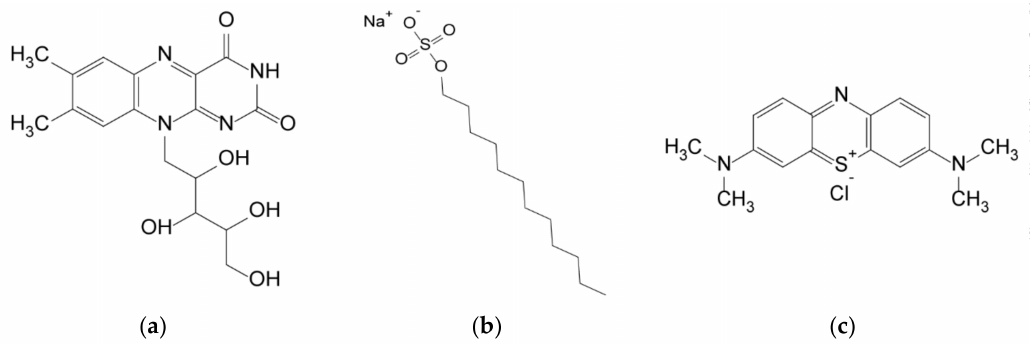
Figure 1. Chemical formula of the three pollutants tested: (a) riboflavin; (b) SDS; (c) methylene blue. The remaining concentration of riboflavin and methylene blue were determined using a Shimadzu UVmini 1240 UV / vis spectrophotometer (Shimadzu, Kyoto, Japan). After adsorption, the solutions were centrifuged at 3000 rpm for 3 min and the absorption of the supernatant was measured at 450 nm for riboflavin and 656 nm for methylene blue. A multipoint calibration curve for both compounds was created ( R 2 =